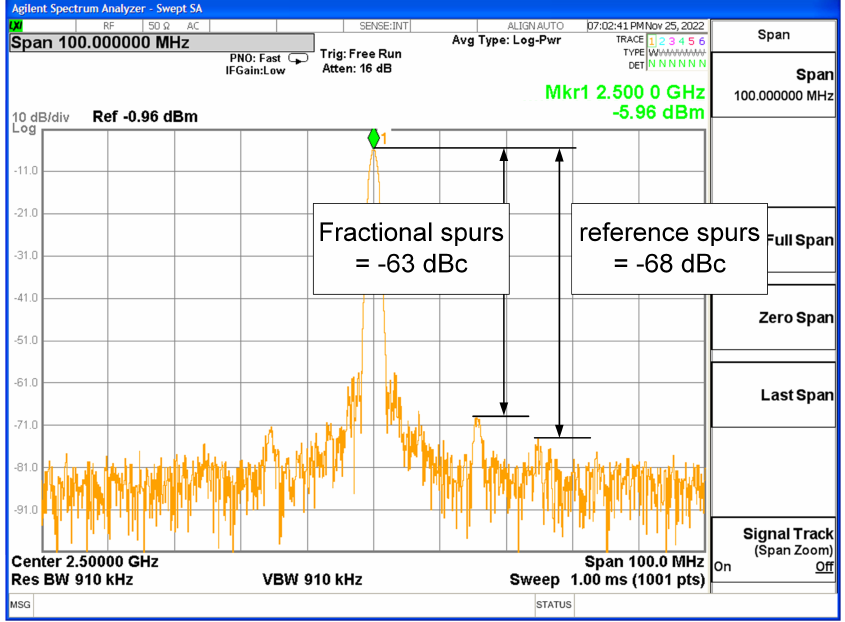
Figure 16. Spectrum of proposed FNPLL with phase interpolation